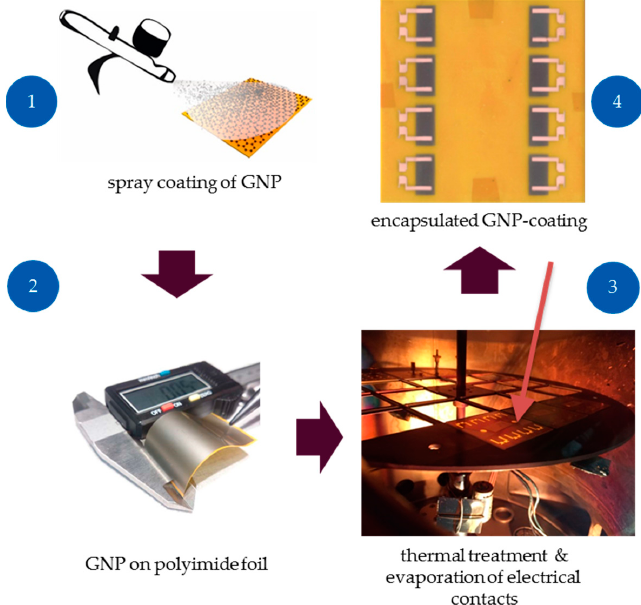
Figure 4. Strain gauge fabrication steps with GNP: spray deposition of GNP (1), GNP on flexible polyimide foil (2), thermal treatment and evaporation of electrical contacts (3), GNP strain gauges after encapsulation (4) [49].